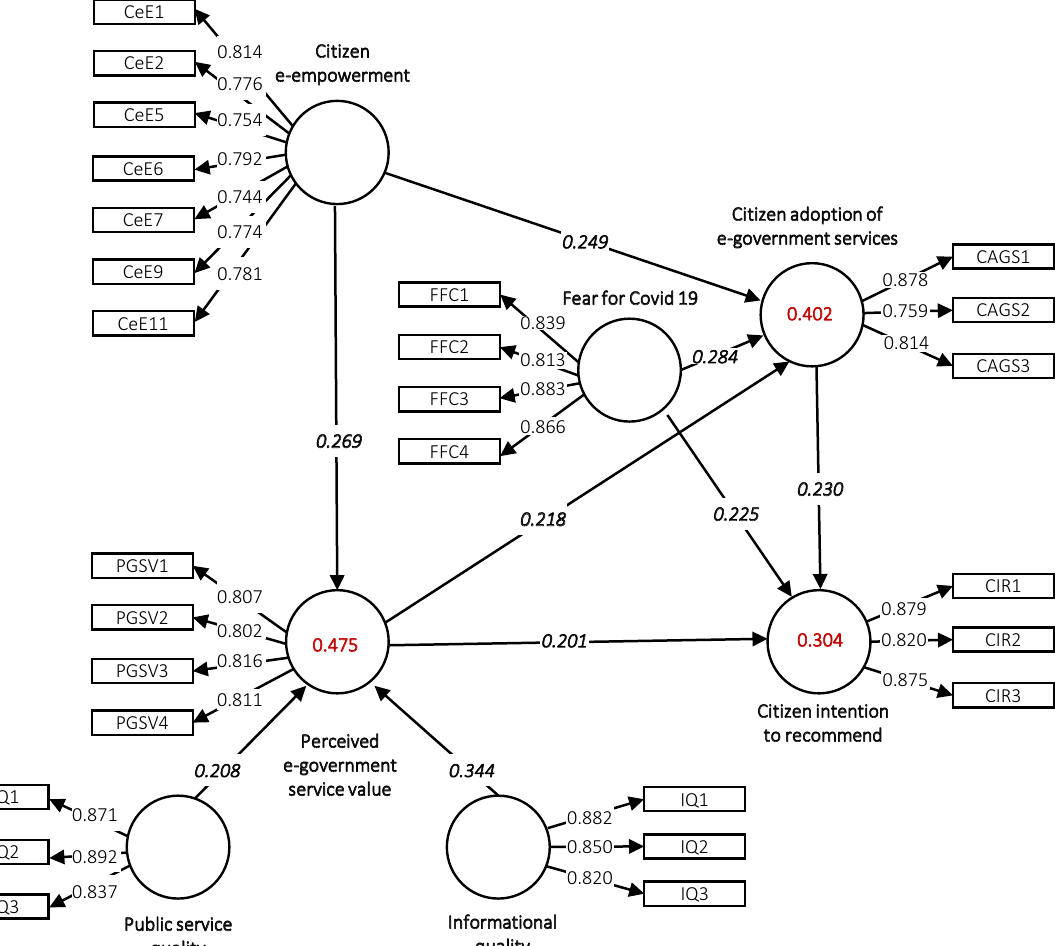
Figure 2. Modeling